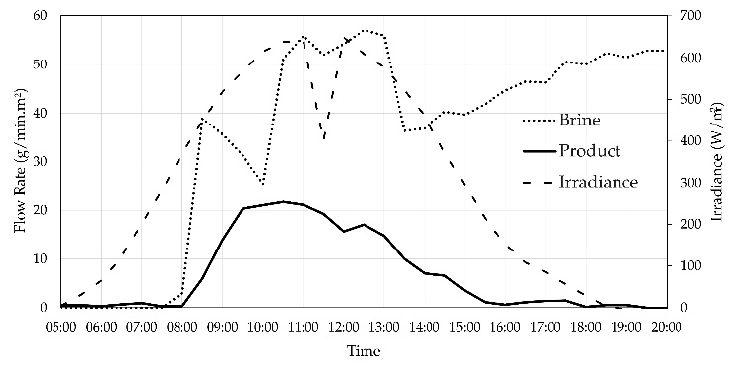
Figure 11. Irradiance and mass flow rate of brine and product of the MSS prototype-2 for one day of operation (Jun 7th).